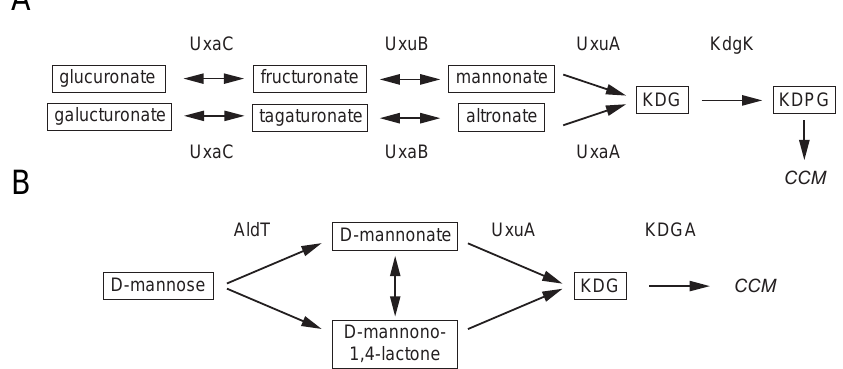
Figure 1. Hexuronate metabolism in E. coli and possible mannose catabolism in T. acidophilum . ( A ) Role of uxuA mannnonate dehdyratase in dissimilation of hexuronates in E. coli adapted from Peekhaus and Conway [8]. ( B ) Role of uxuA mannonate dehydratase in a possible mannose metabolism in T. acidophilum . UxaC: hexuronate isomerase, UxuB: mannonate oxidoreductase, UxaB: altronate oxidoreductase,